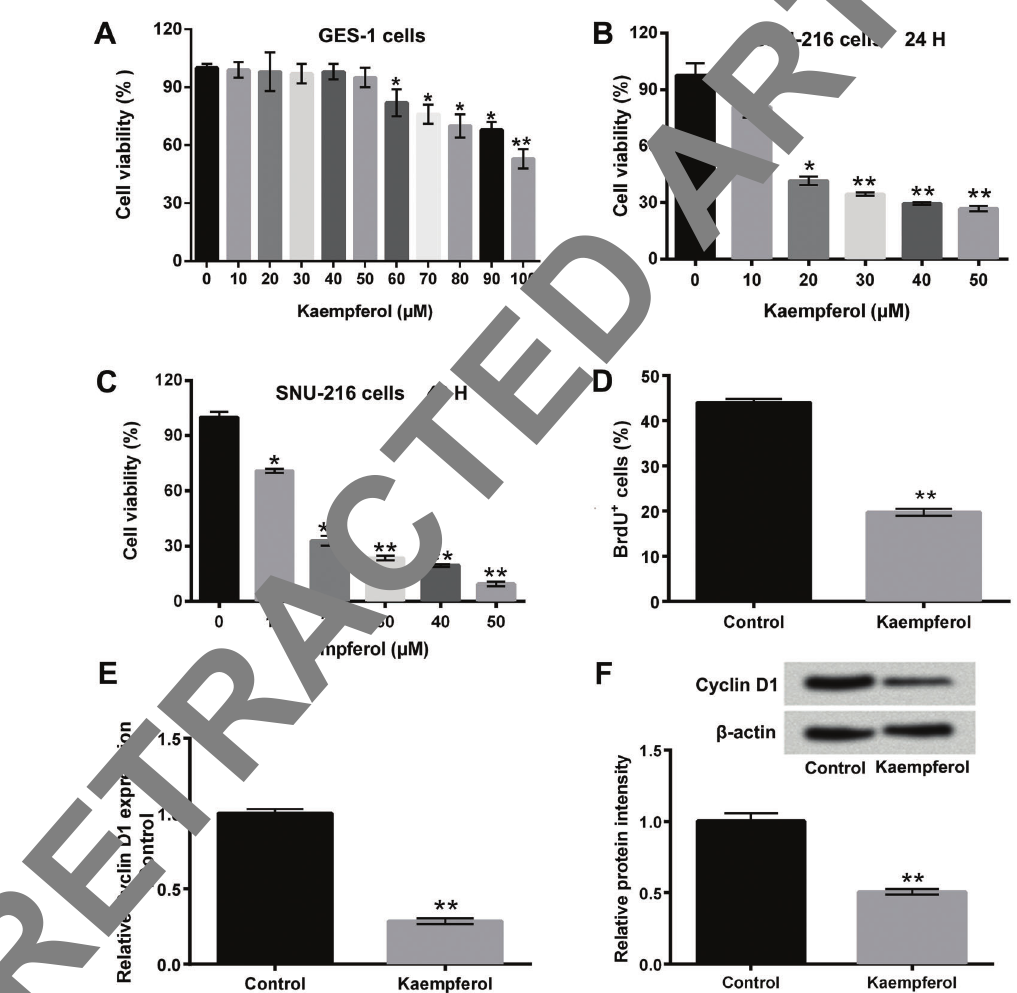
Figure 2. Kaempferol suppressed SNU-216 cell viability and proliferation. A , Viability of GES-1 cells after 10 – 100 m M kaempferol treatment was detected using cell counting kit-8 assay. B and C , Viability of SNU-216 cells after 10 – 50 m M kaempferol treatment for 24 and 48 h were measured using CCK-8 assay. D , Proliferation of SNU-216 cells after 50 m M kaempferol treatment was evaluated using 5-bromo-2 0 -deoxyuridine incorporation assay (BrdU). E and F , mRNA and protein expression levels of cyclin D1 in SNU-216 cells after 50 m M kaempferol treatment were determined using quantitative reverse transcription PCR and western blotting, respectively. Data are reported as means ± SD. *P o 0.05, **P o 0.01 (ANOVA or t